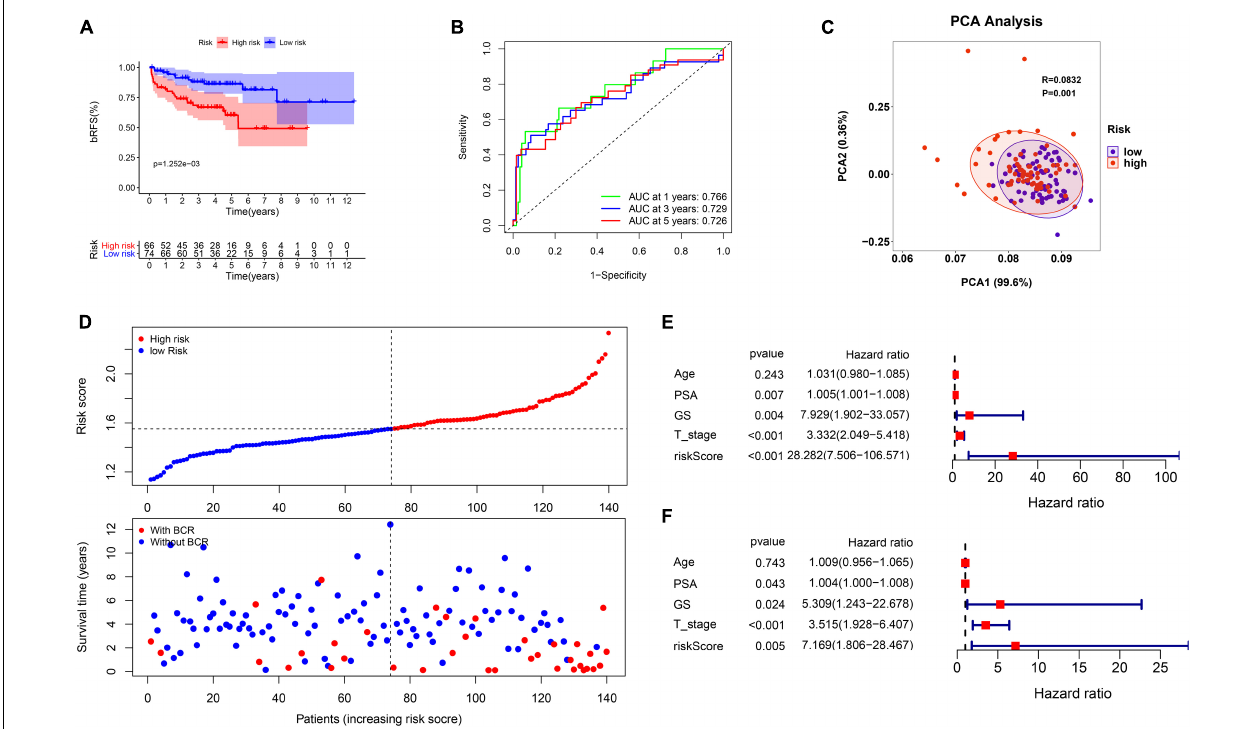
FIGURE 5 | The validation of prognostic signature in MSK-IMPACT Clinical Sequencing Cohort (MSKCC) cohort. (A) The bRFS analysis of the two subgroups stratified based on the median of risk scores calculated by the risk model. (B) ROC curve of model and clinical characteristics predicting 1-, 3-, and 5-year bRFS. (C) The two risk groups were distinguished by PCA. (D) The curve of risk score and BCR status of the patients. (E,F) Univariate and multivariate Cox regression analyses showed that the risk score had prominent prognostic values.